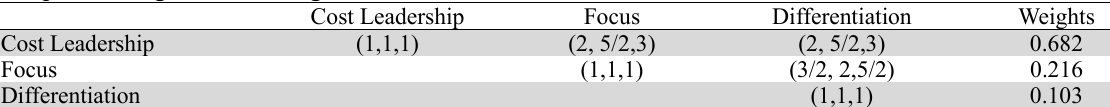
Computed weights for strategies Cost Leadership Focus Differentiation Weights Cost Leadership (1,1,1) (2, 5/2,3) (2, 5/2,3) 0.682 Focus (1,1,1) (3/2, 2,5/2) 0.216 Differentiation (1,1,1) 0.103